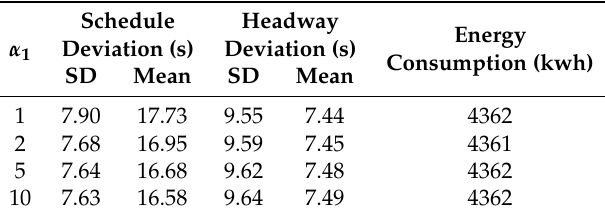
Table 2. The effects of α 1 on the regulation